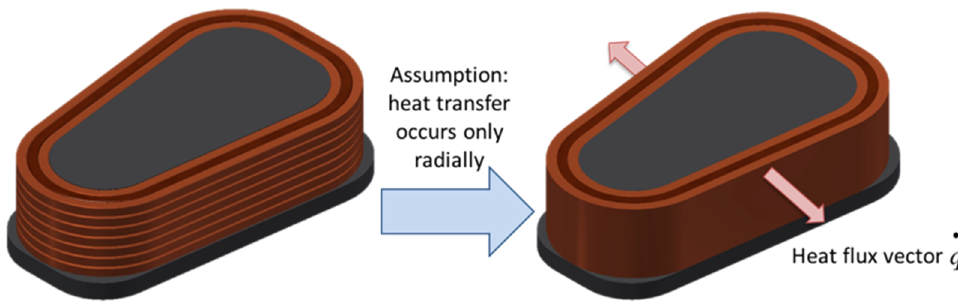
Figure 3. Simplification of the winding geometry. (Figure showing a cross section of the pole piece for better demonstration purposes).